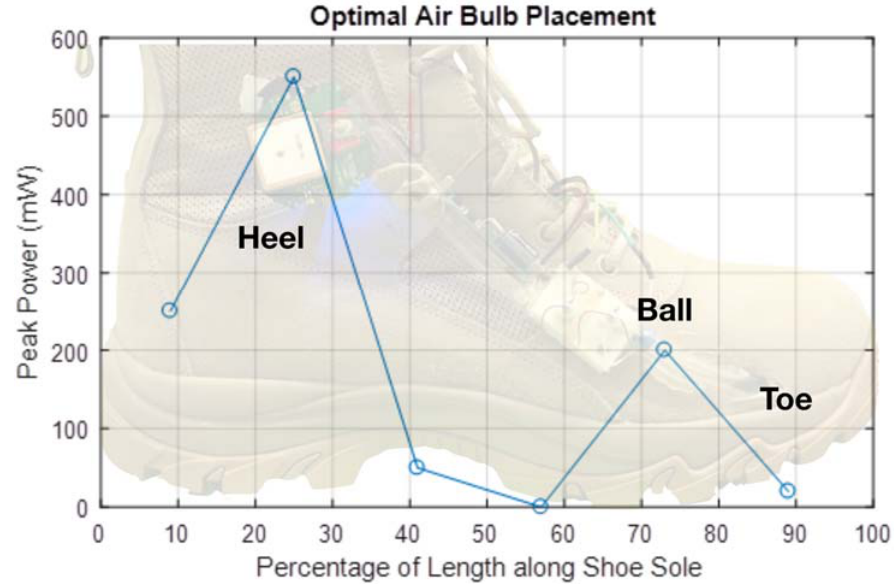
Figure 2. Peak power relative to length along shoe.